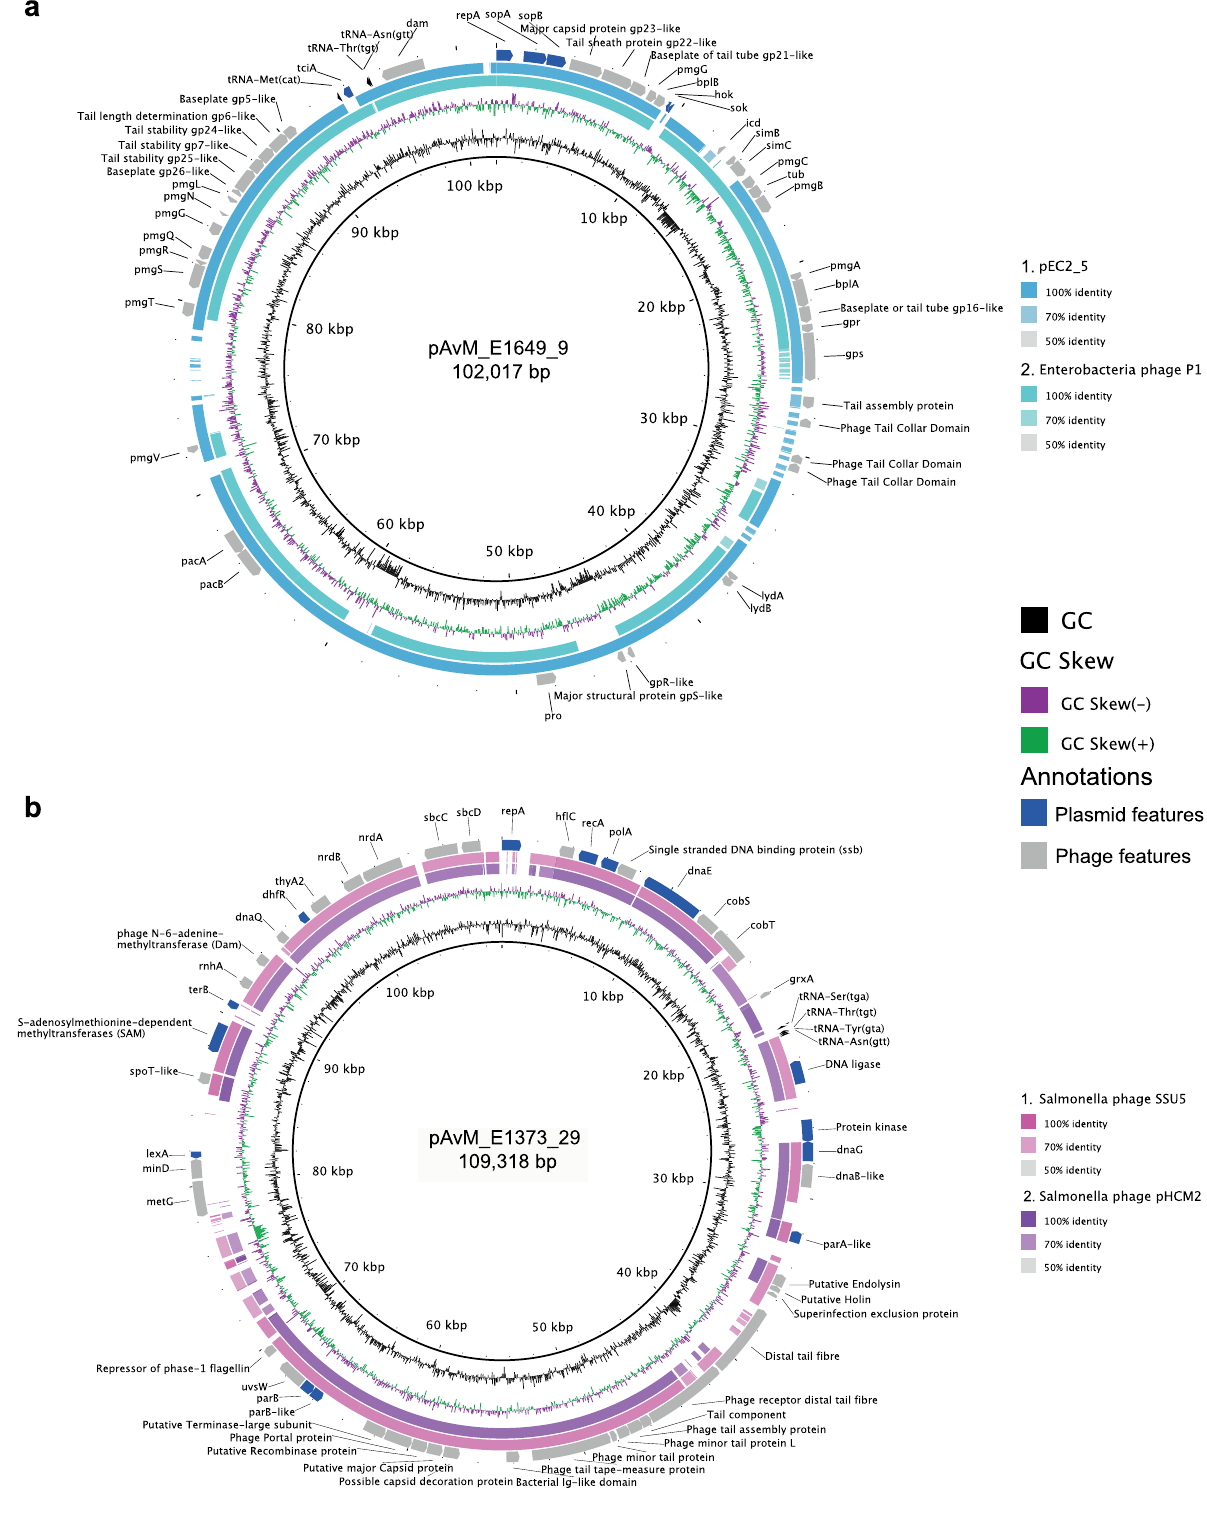
Figure 2. Comparisons between the identified ETEC phage-plasmids and other similar phage-plasmids using blastn. a) pAvM_E1649_9 is a P1-like phage-plasmid here compared to Enterobacteria phage P1 ( Escherichia virus P1; NC_005856.1) and pEC2_5 ( E. coli strain EC2_5; CP041960.1). b) pAvM_E2980_29, a phage-plasmid similar to the pHCM2 ( Salmonella Typhi strain CT18; AL513384.1) and SSU5 ( Salmonella phage; JQ965645.1) in Salmonella Typhi. Blastn comparisons were made using BRIG 36 (v0.95, http:// brig. sourc eforge. net/) with the thresholds indicated to the right of each plasmid comparison. Selected phage and plasmid annotations are shown in the outer